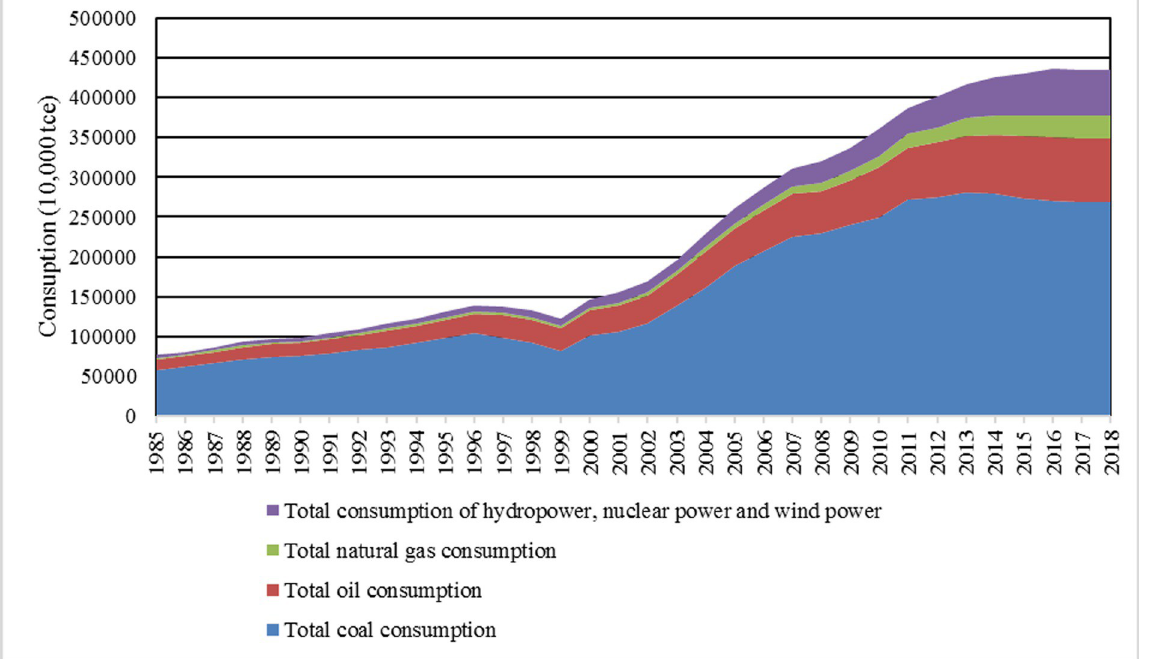
Fig 2. China’s total energy consumption and its composition from 1985 to